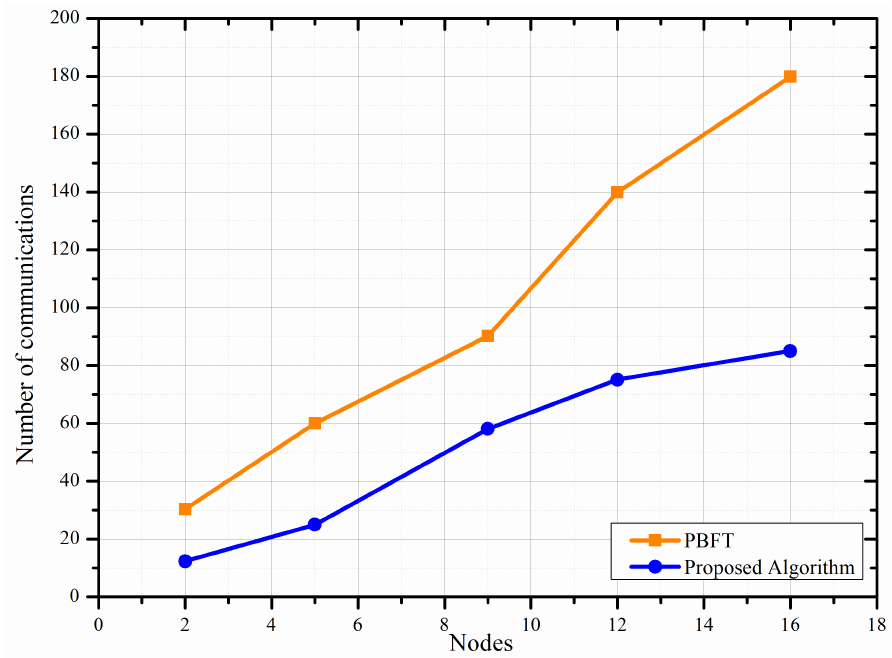
Figure 10. Communication between